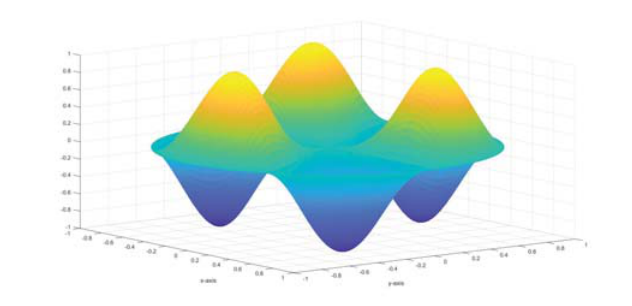
Fig. 3: Eigenfunction of the linearization at the radially symmetric solution with two nodal regions for p=1.7, corresponding to the zero-crossing eigenvalue